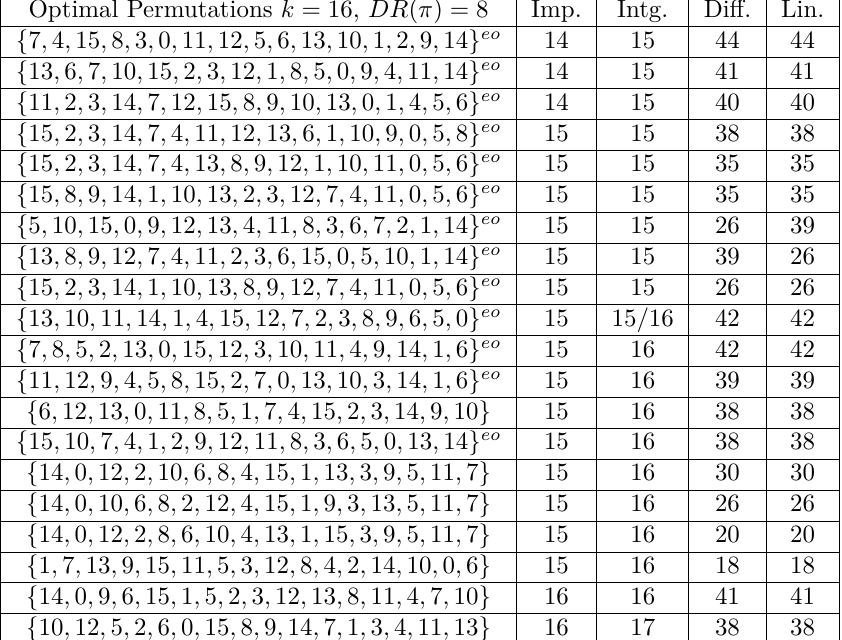
Table 16: Optimal permutations for k = 16 up to extended pair-equivalence Optimal Permutations k = 16, DR ( π ) = 8 Imp. Intg. Diff. Lin.